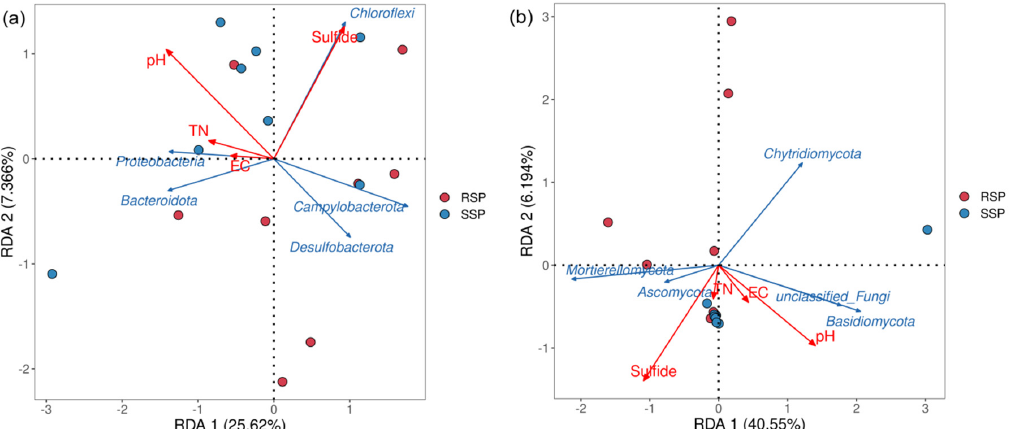
Figure 5. RDA of the relationship between the soil physicochemical properties and bacterial ( a ) and fungal ( b ) genera. RSP, rhizosphere soil samples; SSP, bulk soil samples; TS, total sulfur; TN, total nitrogen; EC, soil electrical conductivity.